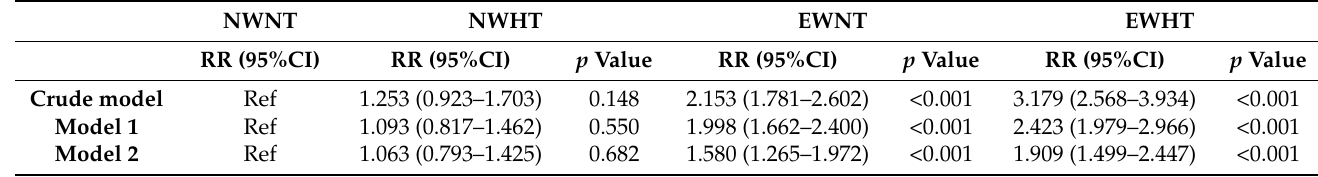
Table 2. Associations between triglyceridemic-waist phenotypes and incident T2DM.